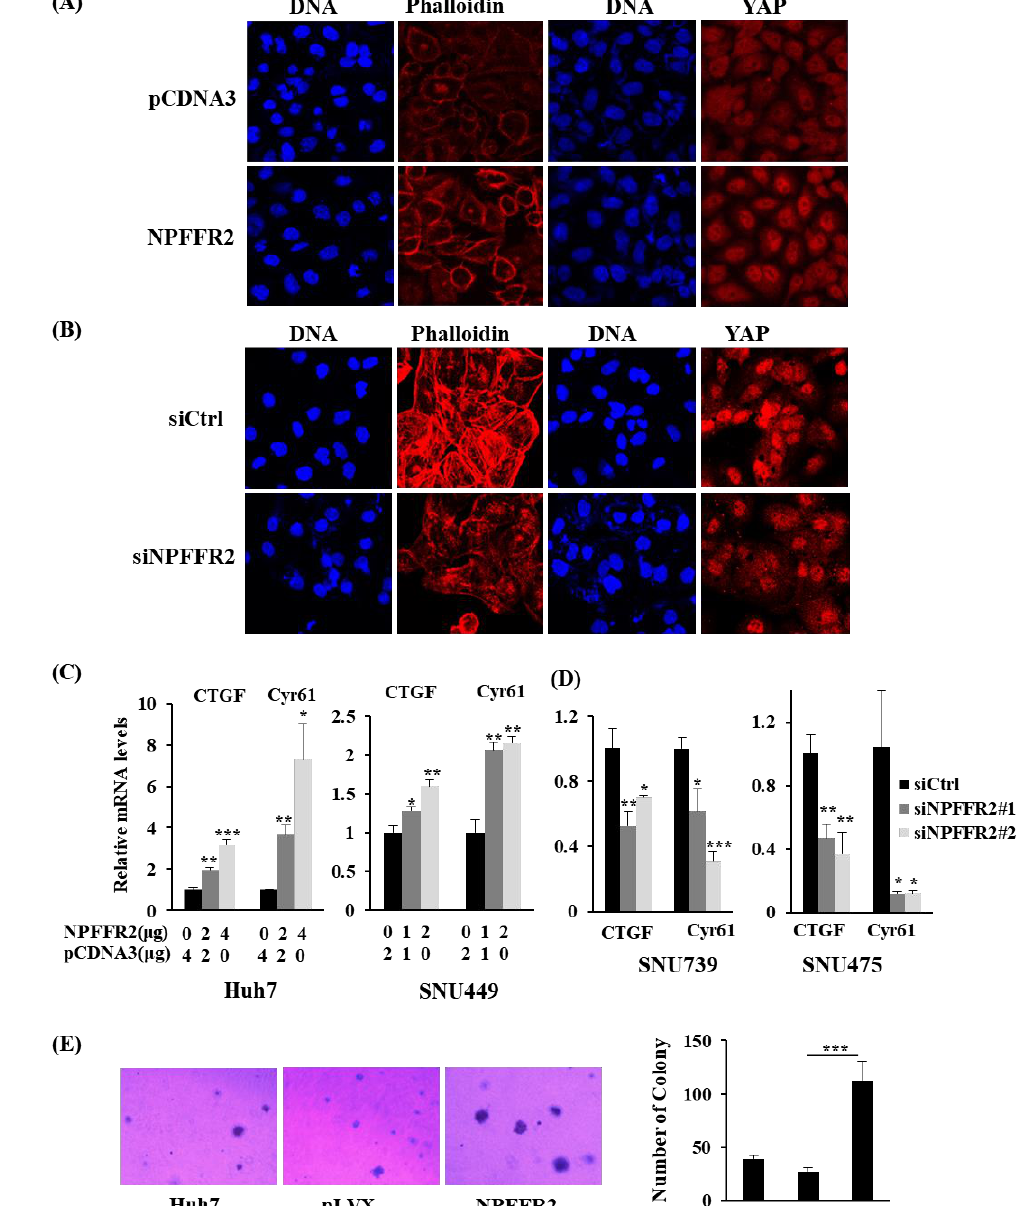
Figure 6. NPFFR2 increases F-actin formation to regulate YAP activation. ( A , B ) Representative confocal image of F-actin and YAP in Huh7 cells overexpressing NPFFR2 ( A ), in SNU475 cells where NPFFR2 is depleted ( B ). F–actin organization was visualized by staining with phalloidin and the control of YAP distribution by NPFFR2 was observed by staining using YAP antibodies. ( C , D ) The control of YAP activity by NPFFR2 was confirmed by analyzing the mRNA expression of CTGF and Cyr61 with real–time PCR. NPFFR2 was overexpressed in Huh7 and SNU449 cells ( C ) and depleted in SNU739 and SNU475 cells ( D ). ( E ) The effect of NPFFR2 overexpression on anchorage-independent cell growth was assessed by soft agar assay using stable cell lines and their parental cells (Huh7). ( C – E ) At least three independent experiments were performed, and data are presented as the average of triplicate ( C , D ) or quadruplicate ( E ) in a representative experiment. * indicates p < 0.05, ** indicates p < 0.01, *** indicates p < 0.001.